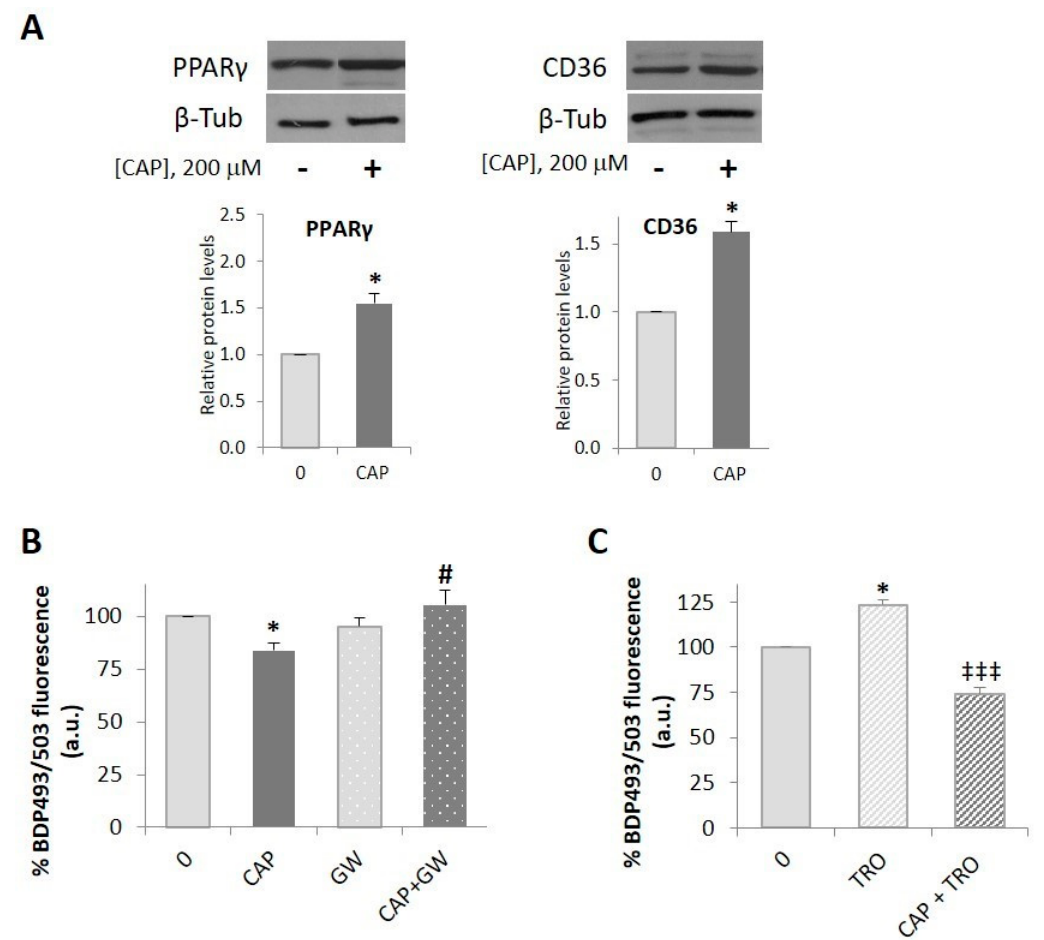
Figure 3. PPAR γ is involved in the capsaicin-induced reduction of neutral lipid content in HepG2 cells. HepG2 cells were cultured in EMEM medium without serum for 24 h. ( A ) Capsaicin upregulated PPAR γ and CD36 protein expression. Cells were pretreated with vehicle or 3 µ M of GW9662(GW) for 30 min and then treated with or without 200 µ M capsaicin for 8 h. Levels of PPAR γ and CD36 were determined by immunoblotting. β -tubulin was used as a loading control. The densitometric analysis of the bands is shown under the blots. Results are the mean ± SEM of three experiments. Statistical significance was determined by the Student’s t test. ( B ) Capsaicin reduced basal neutral lipid content in HepG2 cells. Cells were pretreated with vehicle or 3 µ M of GW9662 for 30 min and then treated with or without 200 µ M capsaicin (CAP) for 24 h. ( C ) Capsaicin inhibited troglitazone-induced neutral lipid accumulation in HepG2 cells. Cells were pretreated with vehicle or 10 µ M of troglitazone (TRO) for 30 min and then treated with or without 200 µ M capsaicin (CAP) for 24 h. Intracellular neutral lipids were stained with bodipy 493/503 (BDP 493/503) for 30 min and fluorescence was measured by flow cytometry to quantify neutral lipid content. The fluorescence intensity of untreated cells (0) was used as the control and the rest of values were expressed as % of the control value. Results are the mean ± SEM of four experiments. Statistical significance was determined by one-way ANOVA and Tukey’s multiple comparisons test. Comparisons were vs. control (* p < 0.05), capsaicin-treated cells (# p < 0.05), or troglitazone-treated cells (‡‡‡ p < 0.005).